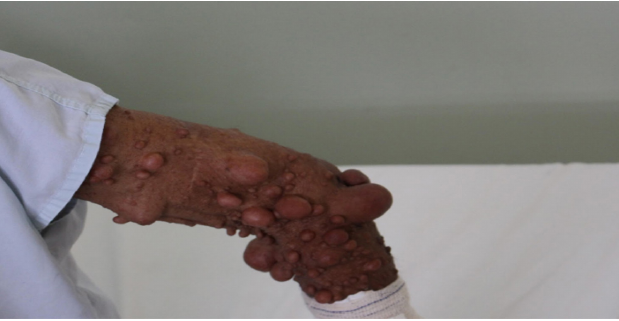
FIGURA 1 – Presença de múltiplos nódulos difusos em todo o corpo